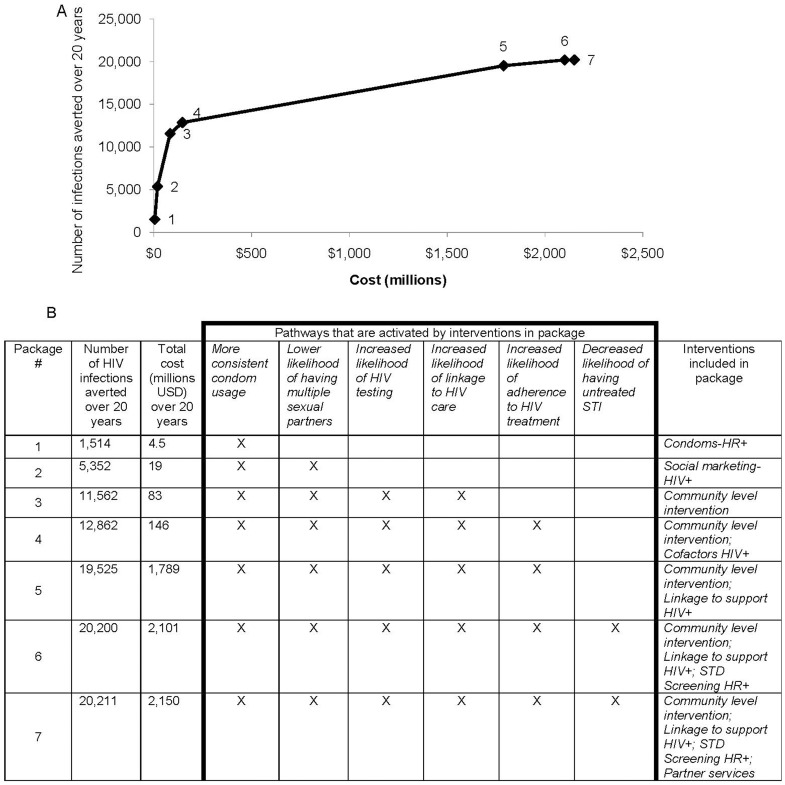
Efficient frontier for HIV prevention interventions found to have “favorable value” during a 20 year simulation of HIV epidemic in NYC.
a. Graphical representation of frontier. Diamonds represent packages of intervention(s) on the frontier. b. Interventions and the pathways they activate contained within each efficient frontier package. X, pathway activated within package.